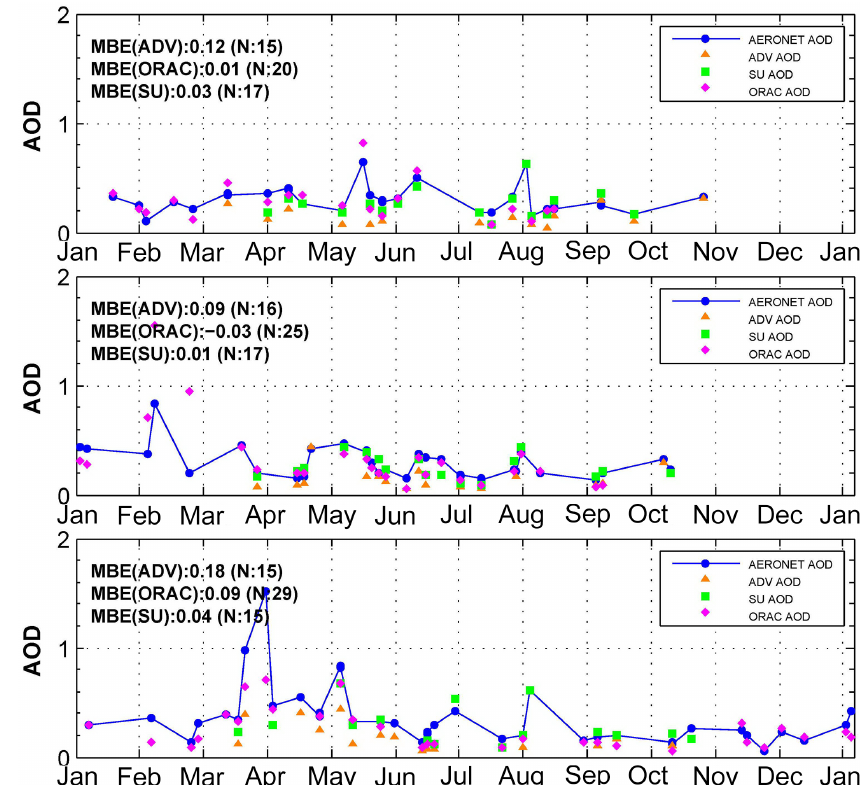
Figure 6. Time series comparison of AATSR AOD with AERONET AOD at SACOL in 2007, 2008, and 2010.